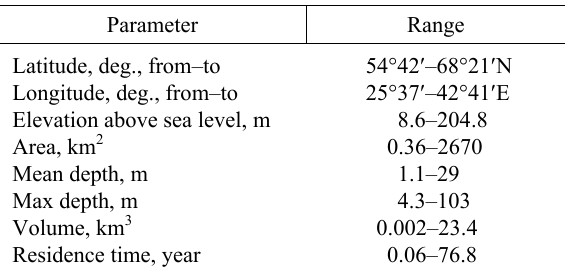
Table 1. С haracteristics of the lakes